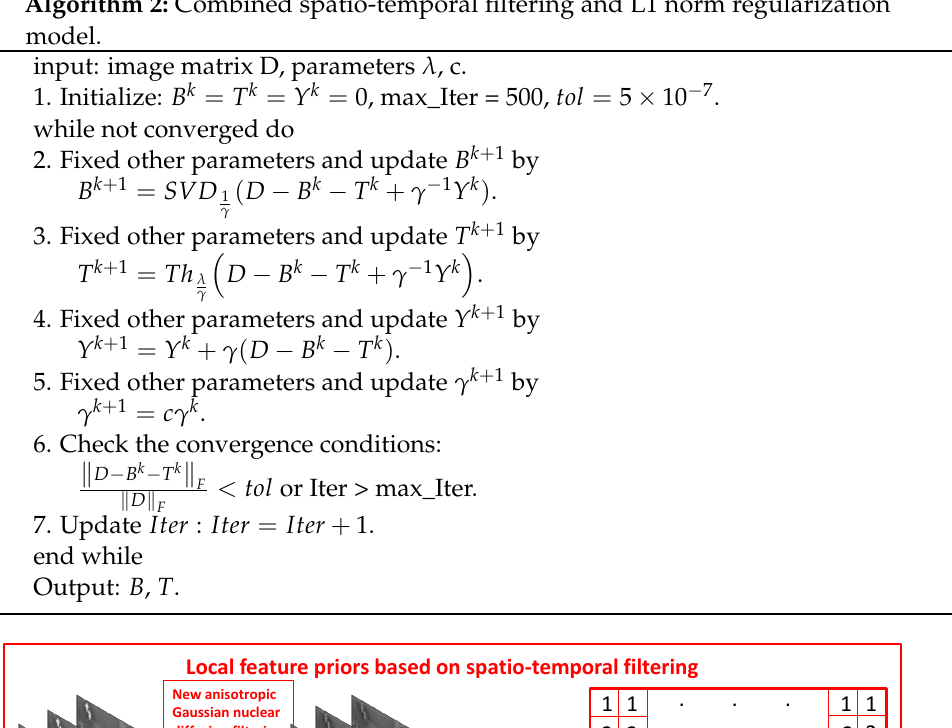
Algorithm 2: Combined spatio-temporal filtering and L1 norm regularization model.